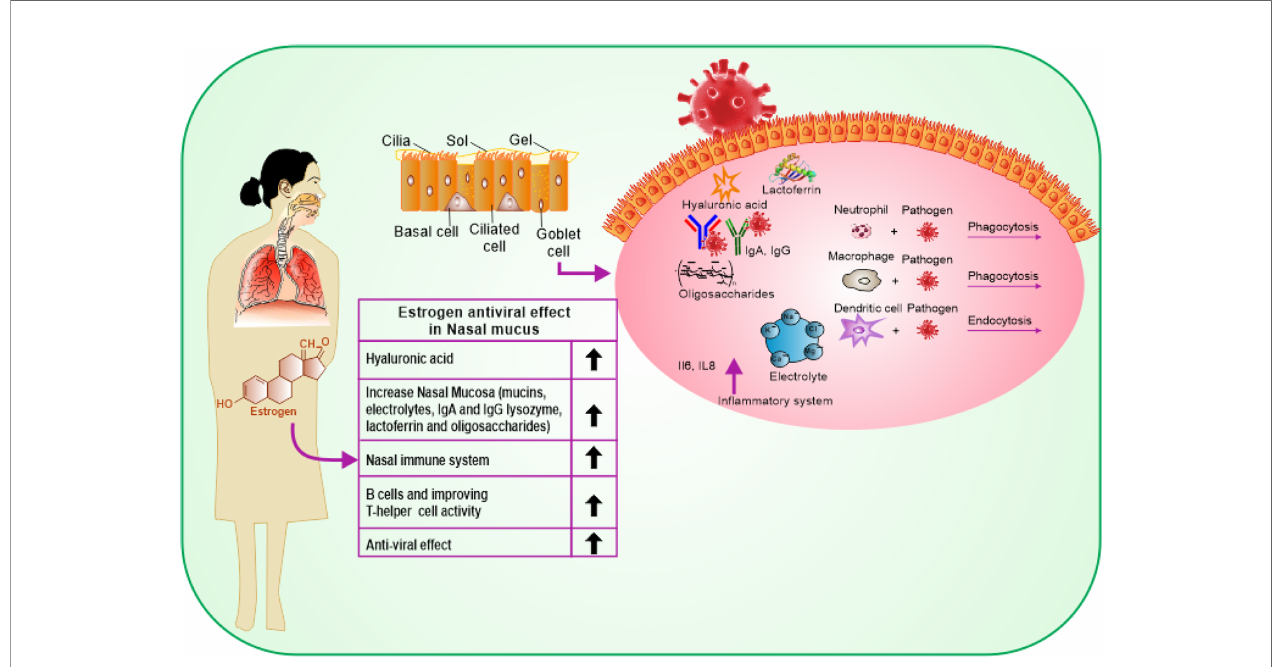
FIGURE 2 | Schematic representation showing the protective effects of estrogen on the upper and lower respiratory tract cells and its bene fi ts on the immune